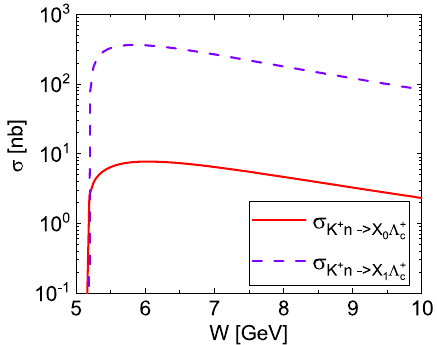
Fig. 5 The energy dependence of the total cross section for the pro- ductions of the X 0 and X 1 in K + n collisions with α = 1 . 5